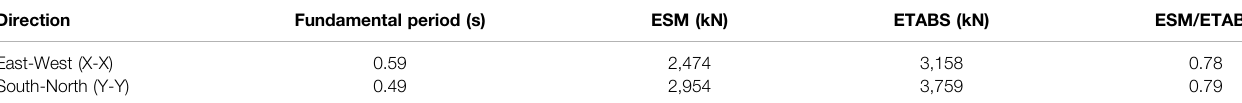
TABLE 4 | Comparison of base shear under equivalent static method (ESM) and mode-superposition method in ETABS.